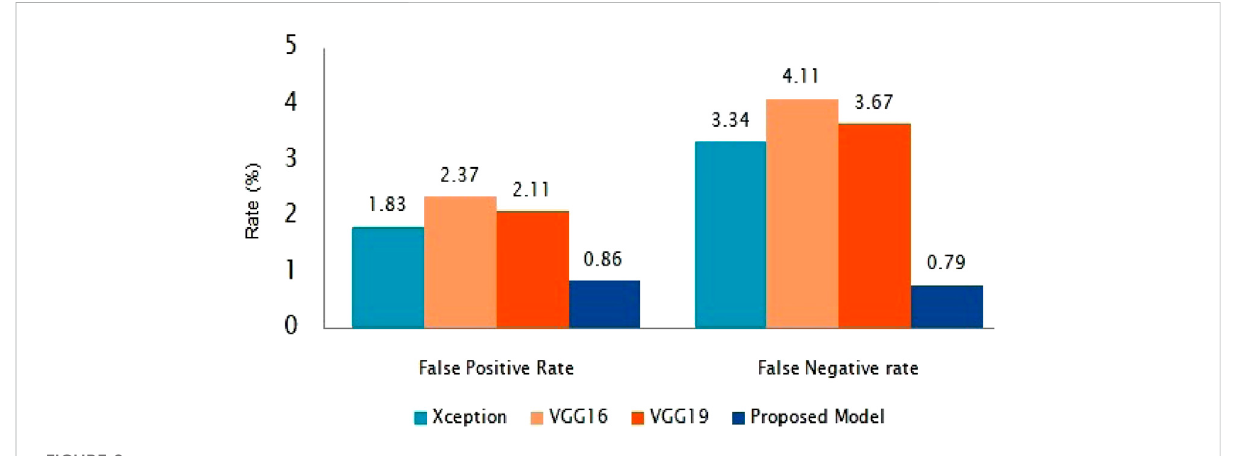
FIGURE 8 FPR and FNR bar graphs for the proposed model with different models.